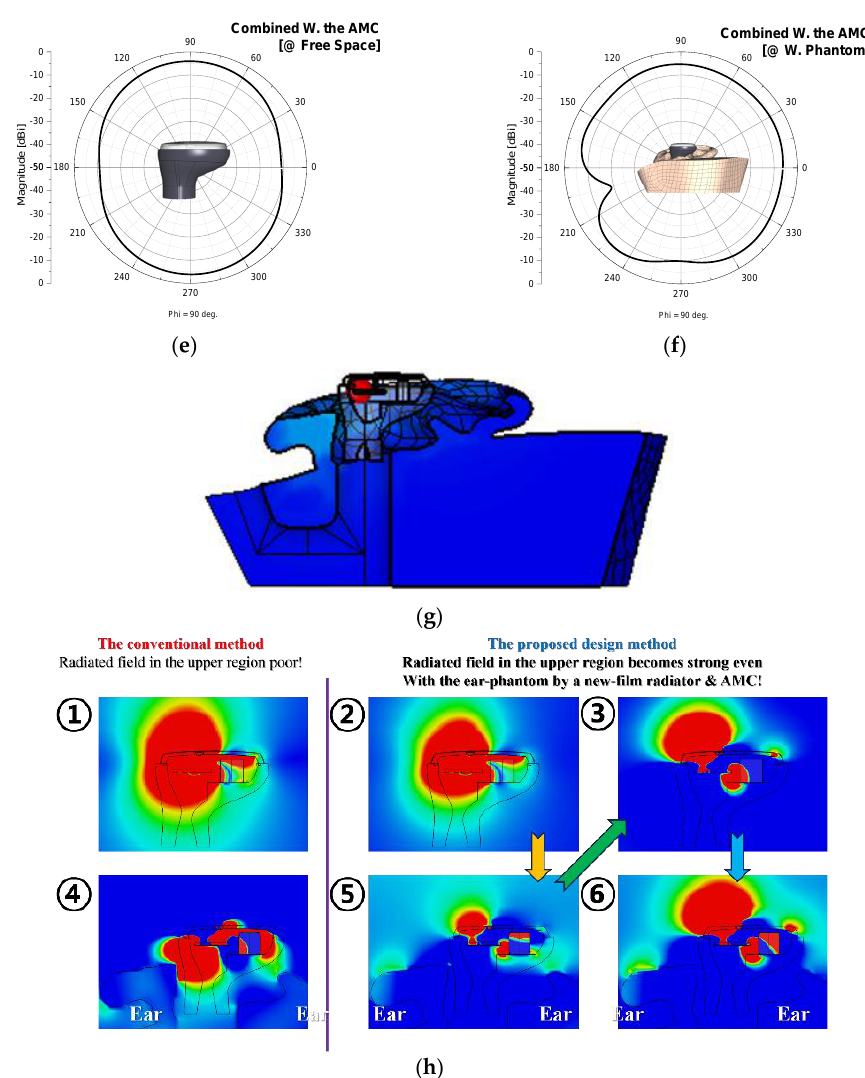
Figure 4. On− film antenna earbud in free space: ( a ) combined with the AMC; ( b ) layer structure; ( c ) geometry of the AMC; ( d ) S 11 ; ( e ) radiated field pattern in free space; ( f ) radiated field pattern attached to the human phantom; ( g ) SAR; ( h ) comparison of upward near-field strength.